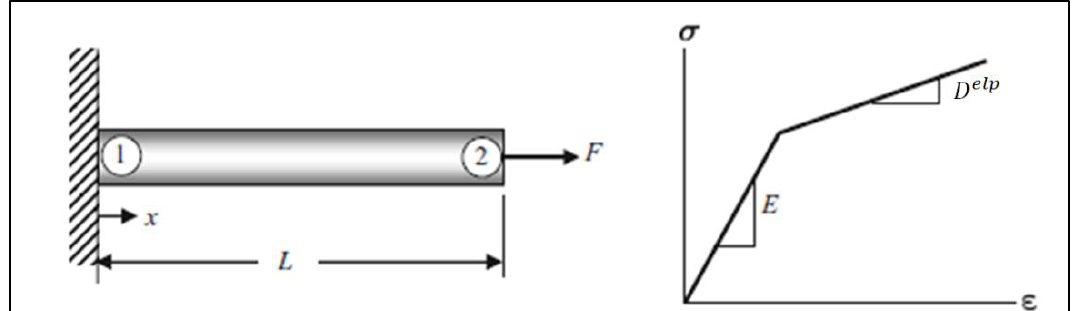
Figure 5. Nonlinear bar problem [14].